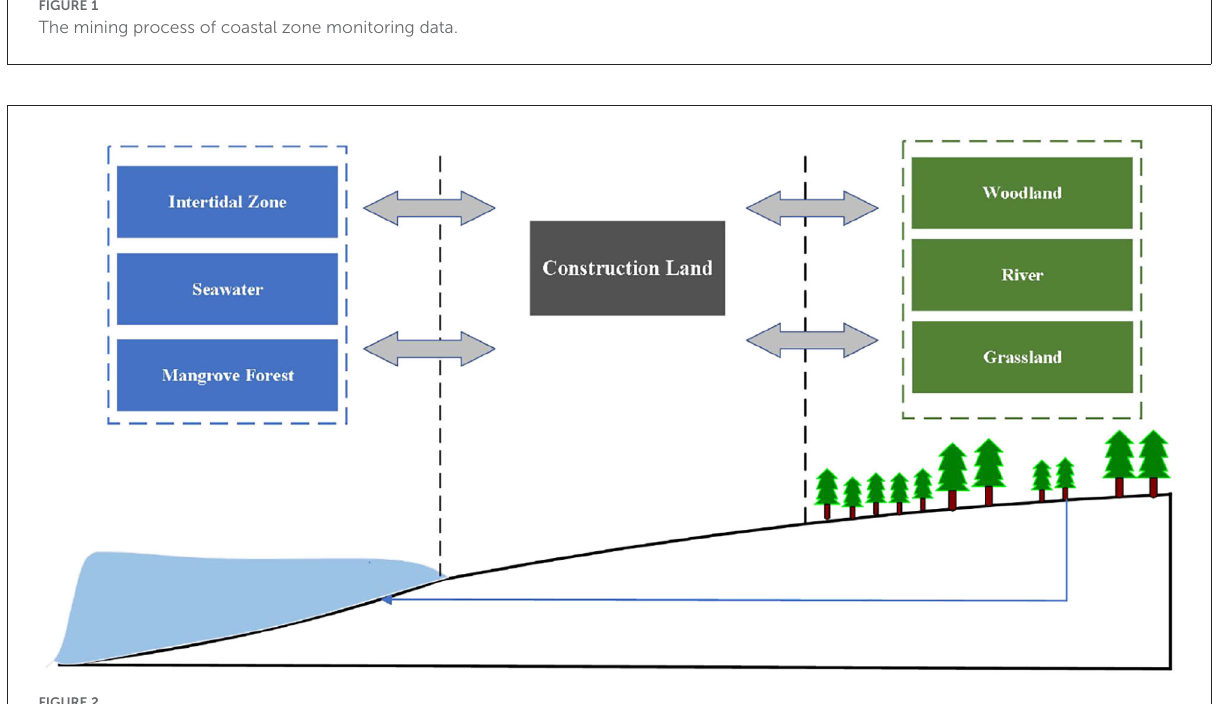
FIGURE2 Carbon metabolism in the coastal